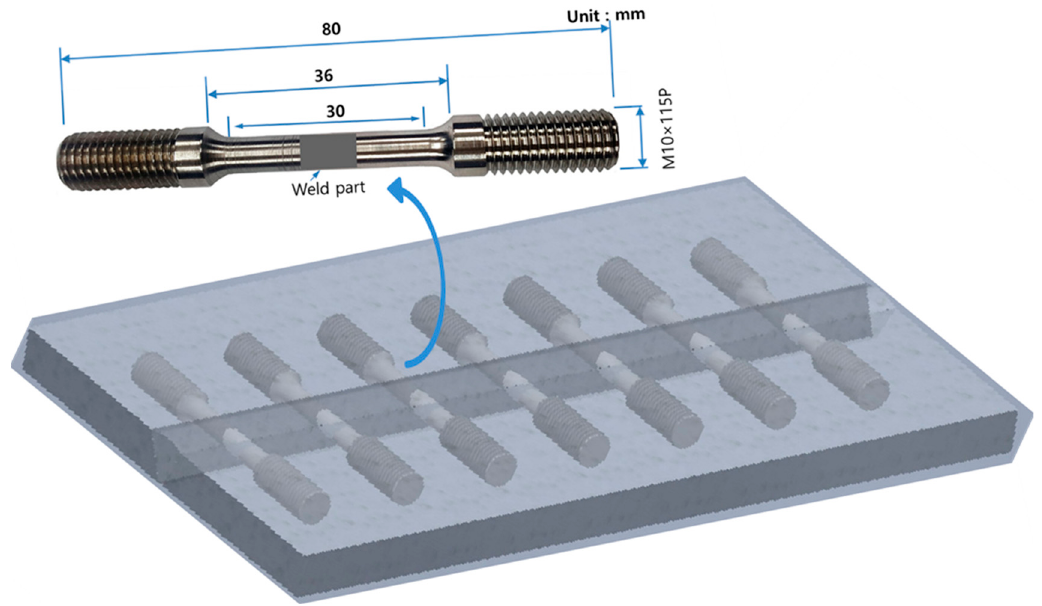
Figure 2. Fatigue test specimen configuration.